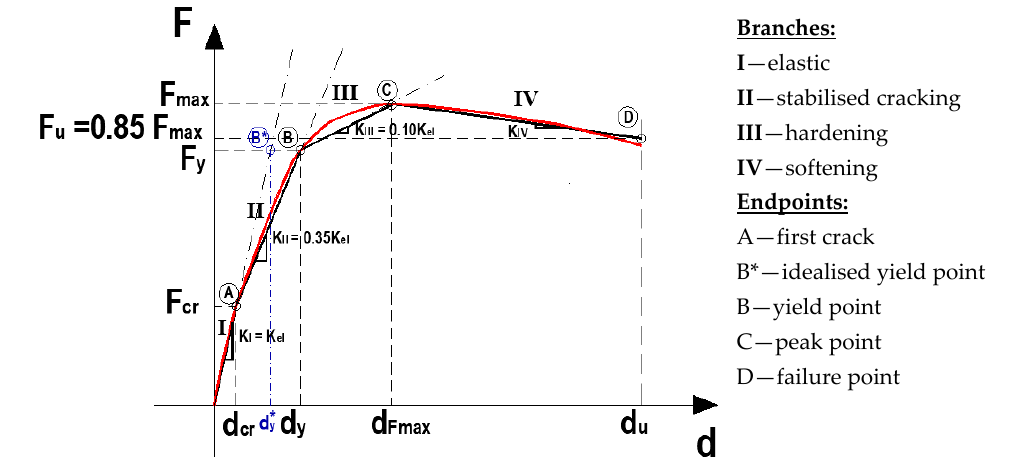
Figure 19. Experimental envelope response (red) and proposed multilinear curve (black).